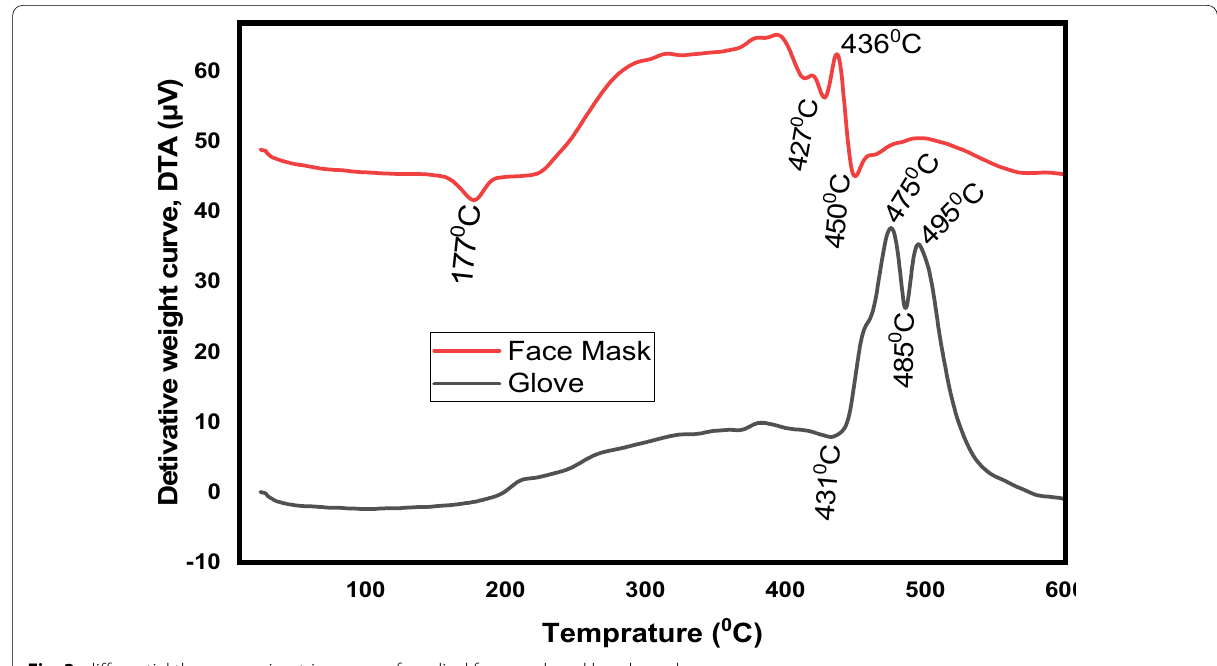
Fig. 3 differential thermogravimetric curves of medical face mask and hand-on gloves